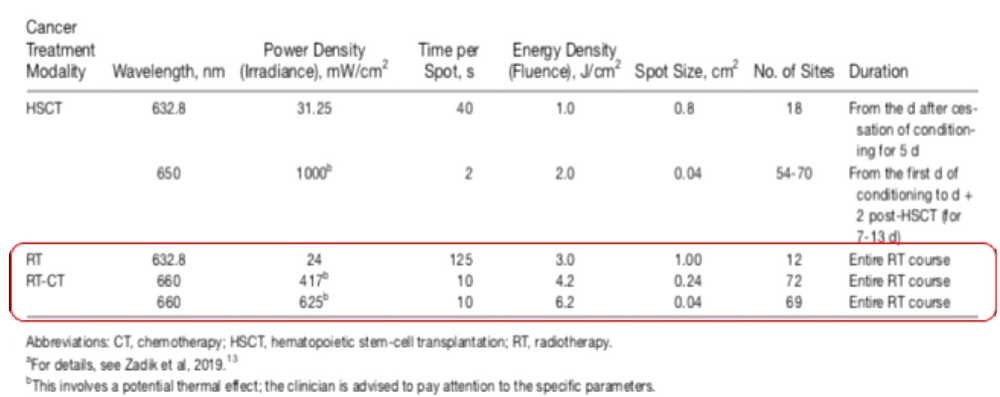
Fig. 2. Intraoral PBM protocols for the prevention of OM in HNSCC boxed in red